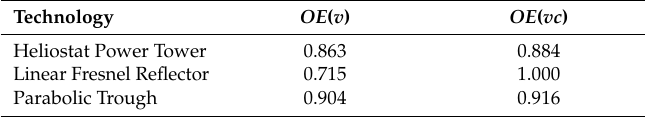
Table 9. Average output-based e ffi ciencies: three technologies.